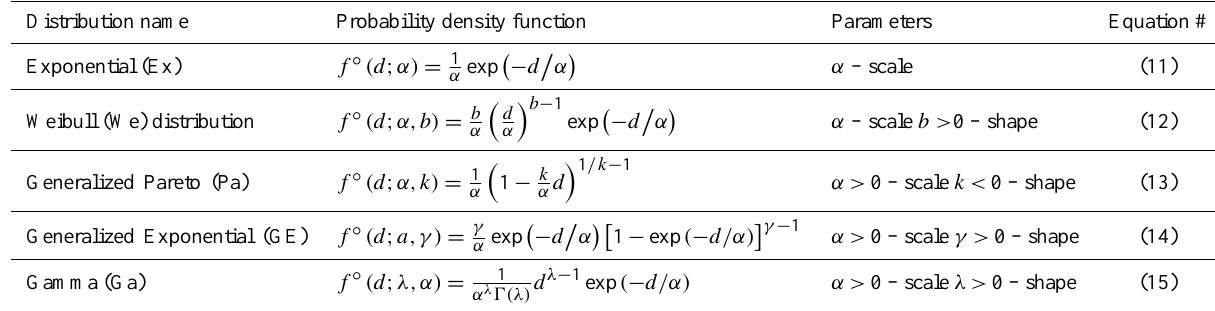
Table 1. Distribution functions recommended as f °( d j ; g )